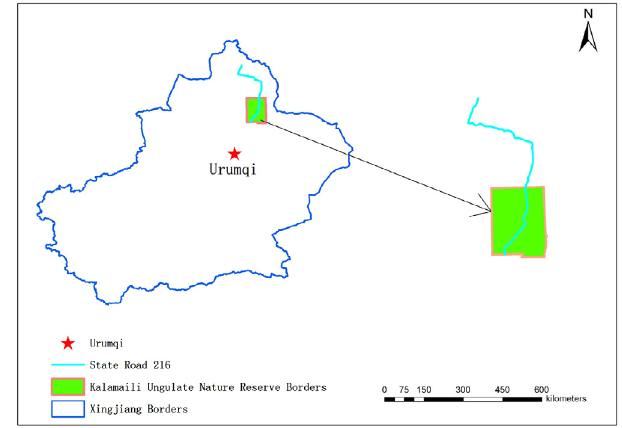
Figure 1. Location of the Kalamaili Nature Reserve in Xingjiang,